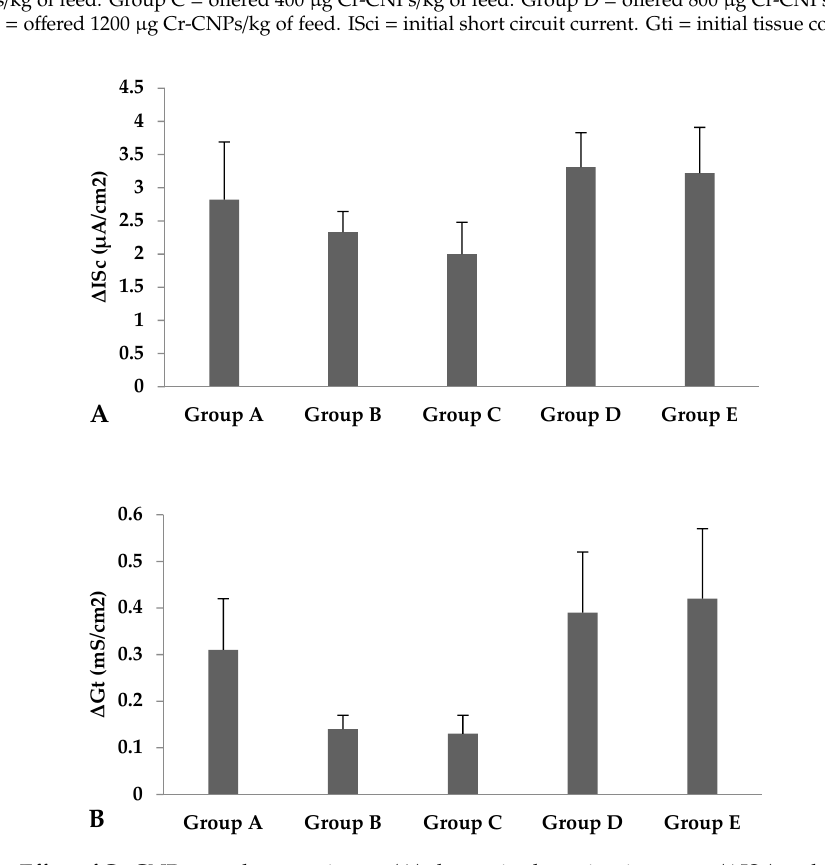
Figure 2. E ff ect of Cr-CNPs supplementation on ( A ) change in short circuit current ( ∆ ISc) and ( B ) change Figure 2. Effect of Cr-CNPs supplementation on ( A ) change in short circuit current ( Δ ISc) and ( B ) in tissue conductance ( ∆ Gt) after addition of L-glutamine to the jejunum in broilers. Mean values with change in tissue conductance ( Δ Gt) after addition of L-glutamine to the jejunum in broilers. Mean di ff erent small letters on the same bar di ff er significantly at p < 0.05. Data are presented as Mean ± SEM. values with different small letters on the same bar differ significantly at p < 0.05. Data are presented Group A = control—without Cr-CNPs supplementation. Group B = o ff ered 200 µ g Cr-CNPs / kg of feed. as Mean ± SEM. Group A = control—without Cr-CNPs supplementation. Group B = offered 200 µg Group C = o ff ered 400 µ g Cr-CNPs / kg of feed. Group D = o ff ered 800 µ g Cr-CNPs / kg of feed. Group Cr-CNPs/kg of feed. Group C = offered 400 µg Cr-CNPs/kg of feed. Group D = offered 800 µg